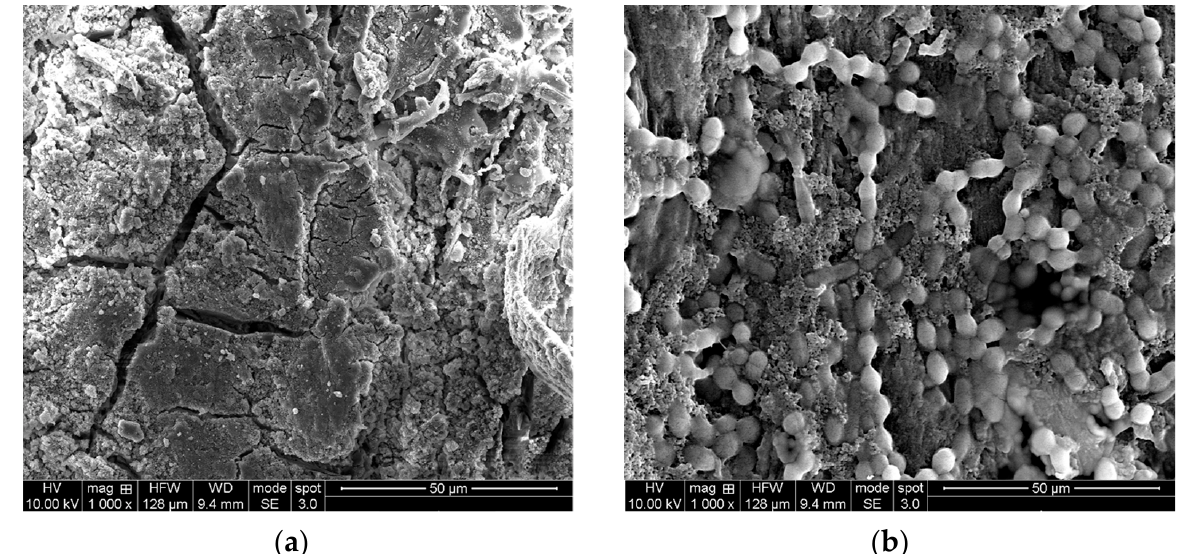
Figure 3. Scanning electron microscopy observations of wooden vat surface. ( a ) Before microbial activation; ( b ) after contact with scotta whey.